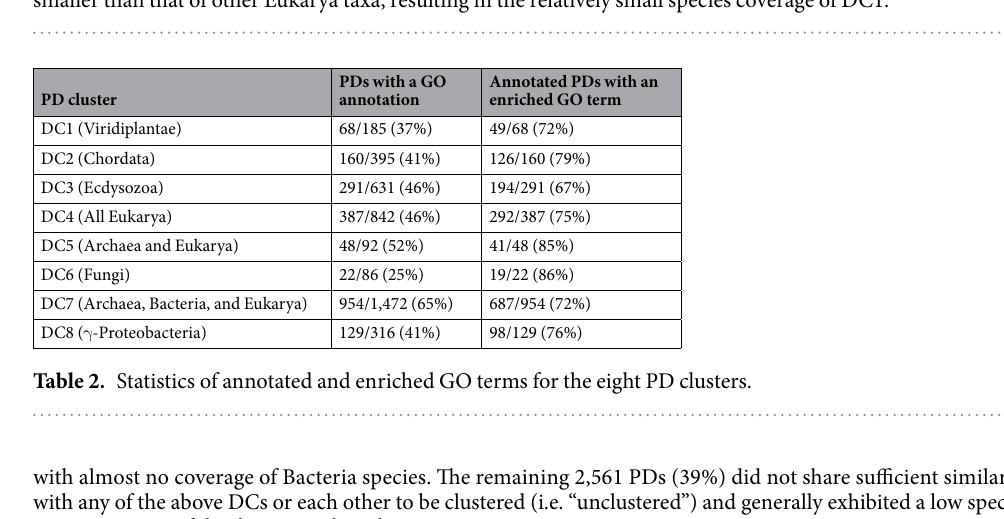
Figure 2. Species coverage of each of the eight PD clusters. A total of 133 Archaea species, 1,653 Bacteria species, and 348 Eukarya species were analyzed (see Methods). The Figure shows the averaged coverage of species in which a domain in a PD cluster (or the collection of unclustered domains) was found to be present; the bar indicates one standard deviation. Note that the number of completely sequenced plant genomes is smaller than that of other Eukarya taxa, resulting in the relatively small species coverage of DC1.